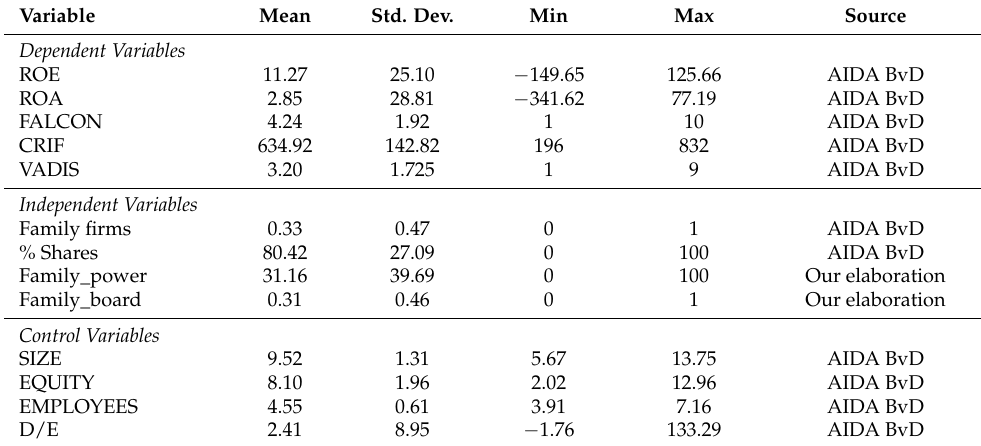
Table 2. Variables